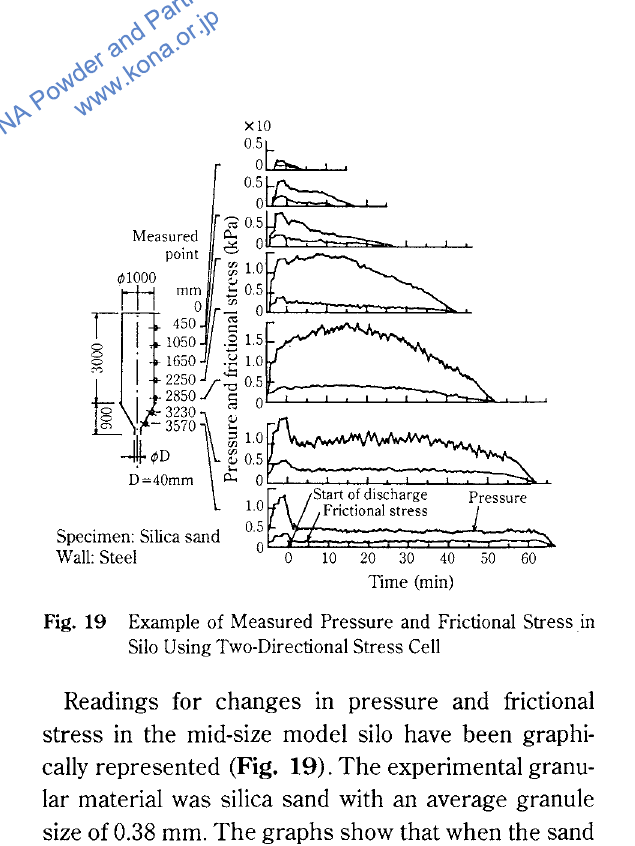
Fig. 19 Example of Measured Pressure and Frictional Stress in Silo Using Two-Directional Stress Cell Readings for changes in pressure and frictional